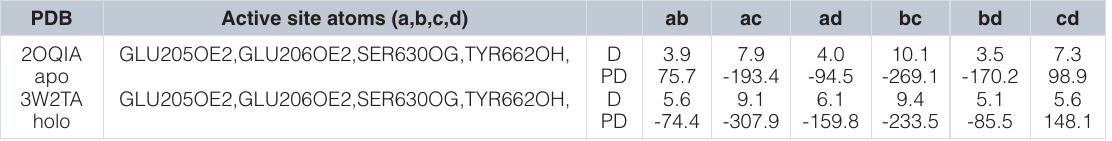
Table 2. Changes in the conformation of the binding site due to vildagliptin (a DPP4 inhibitor) binding. We compare the pairwise distance and electrostatic potential difference (EPD) changes in the apo (PDBid:2OQIA) and holo (PDBid:3W2TA) enzymes. Note that the pairwise distance between these atoms change in the ligand free PDB (2OQIA) as compared to the protein with bound inhibitor (2BUBA). For example, the distance between E205OE2 and E206OE2 (pair ab) changes from 3.9 Å to 5.6 Å. Also, there is a definite change in the EPD between E205OE2 and E205OE2 (pair ab). D = Pairwise distance in Å. PD = Pairwise potential difference. The electrostatic potential are in dimensionless units of kT/e where k is Boltzmann’s constant, T is the temperature in K and e is the charge of an